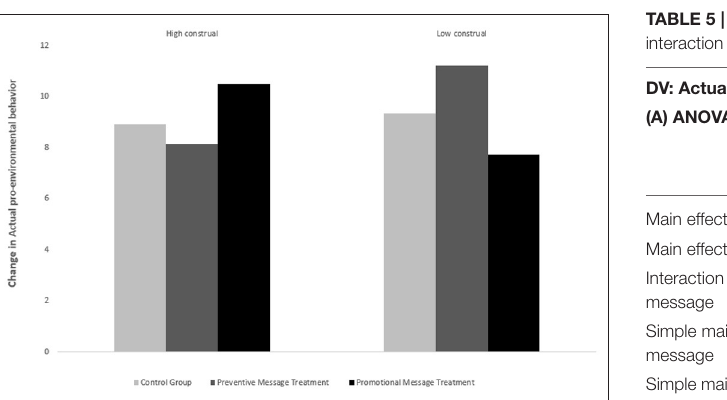
FIGURE 5 | Change in actual pro-environmental